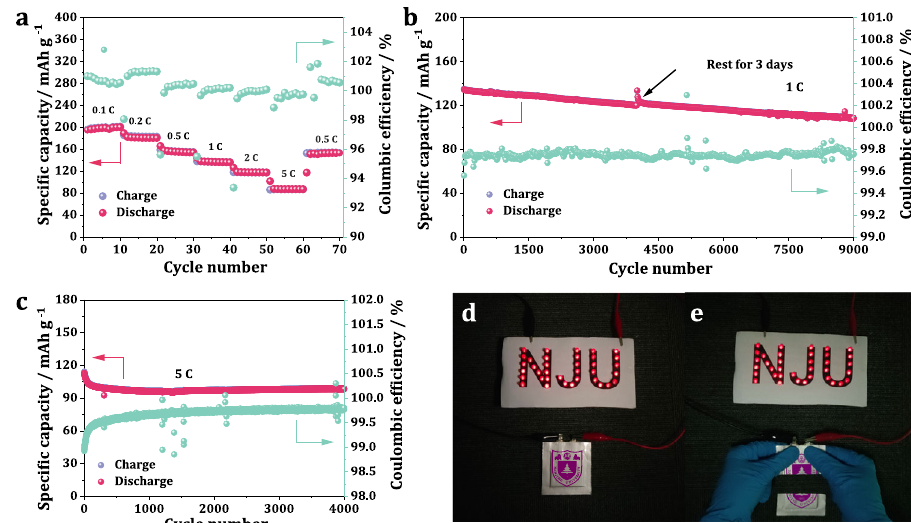
Fig. 4 Electrochemical performance of all-solid-state LIB. a Rate performance of the as-designed all-solid-state LIB. b Cycling stability with the corresponding coulombic ef fi ciency of the pouch type battery at 1C at a I 2 mass loading of 0.5 mg cm − 2 . c Cycling stability with the corresponding coulombic ef fi ciency of the all-solid-state LIB at 5C and at 90 °C. d Photograph of the all-solid-state Li-I 2 pouch cell (40 mm × 40 mm cathode in 60 mm × 60 mm package) powering LED lights. e Illustration of the pouch cell showing high safety and well-running under a condition of being